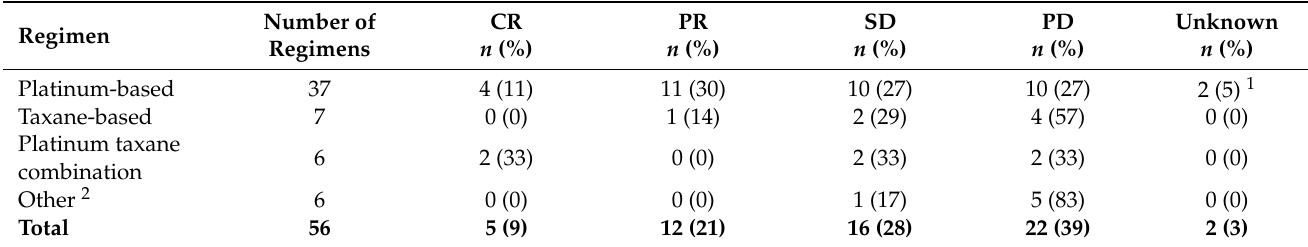
Table 4. Summary of response rates of chemotherapy for aGCT, excluding case